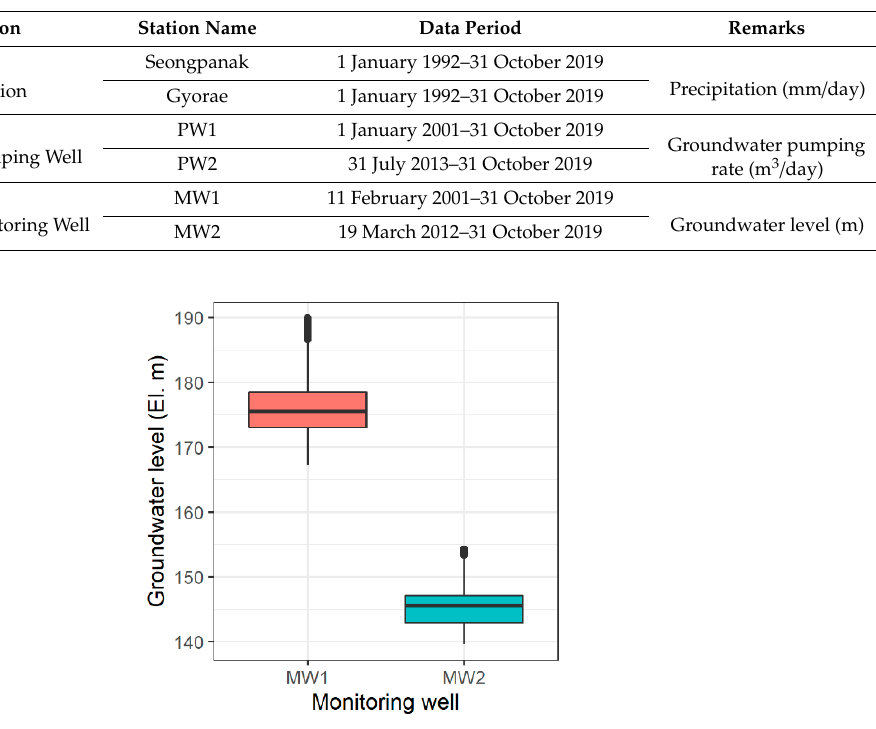
Table 1. Data period of rainfall stations, groundwater pumping wells, and groundwater monitoring wells.